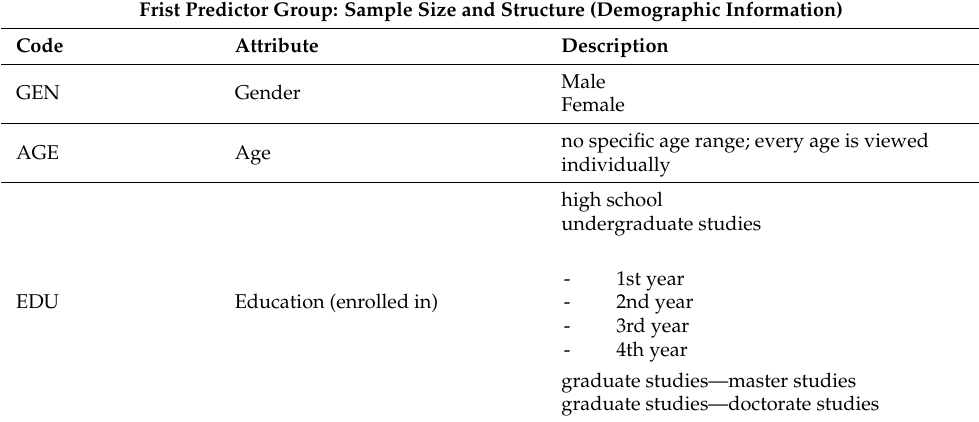
Table A1. Survey items, predictor items, and predictor groups. Frist Predictor Group: Sample Size and Structure (Demographic